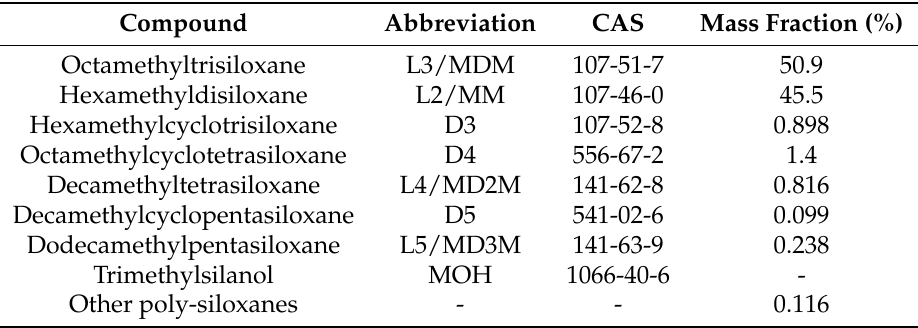
Table 3. HS-GC-MS analysis results of cycle fluid (source: vacuum pump) [11].